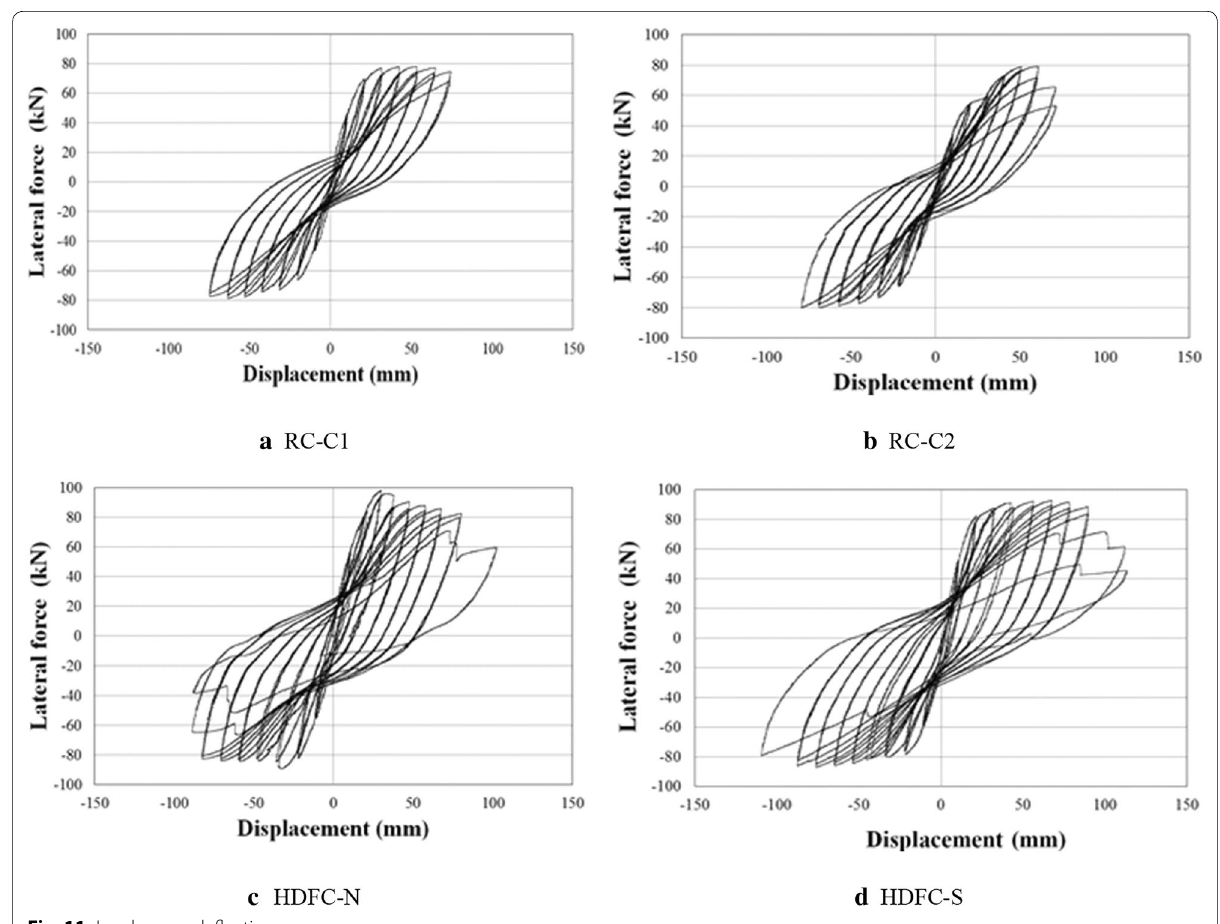
Fig. 11 Load versus deflection curves